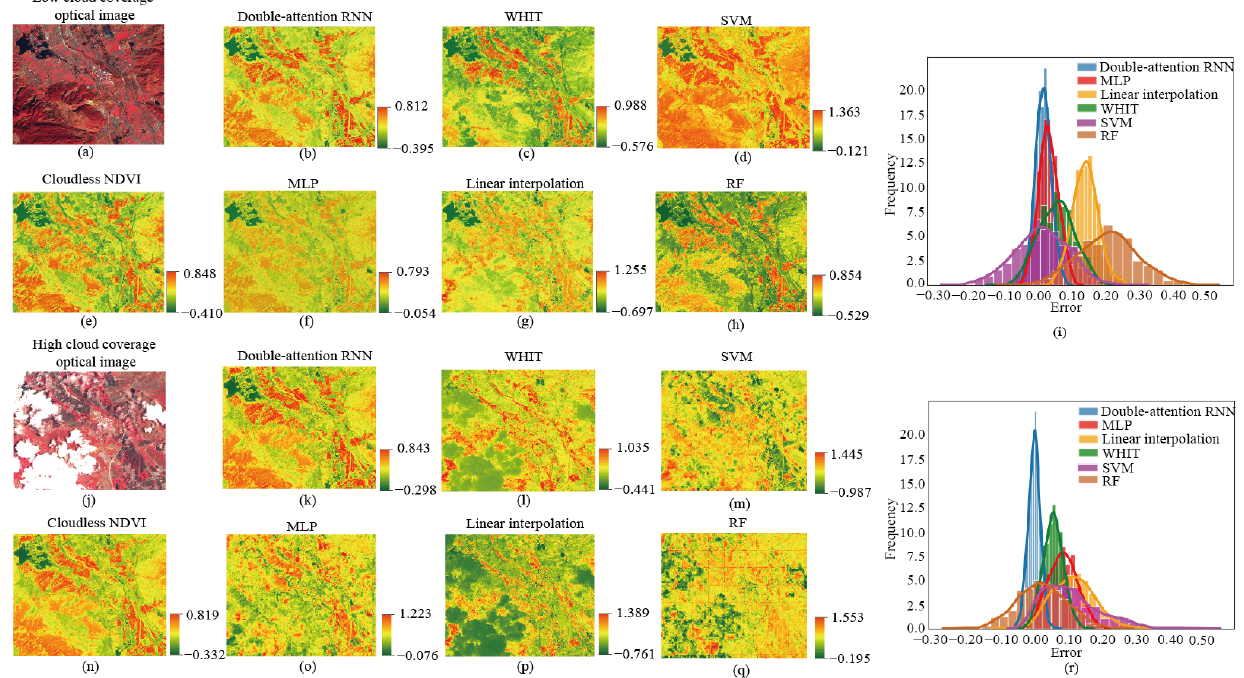
Figure 11. The NDVI retrieval results of the comparative models; ( a , j ) represent the optical images of low cloud coverage and high cloud coverage; ( e , n ) show the cloudless NDVI; ( b – d , f – h , k – m , o – q ) represent the retrieval results of the double-attention RNN, WHIT, MLP, linear interpolation, SVM, and RF; ( i , r ) present the error histogram plots, which integrate a bar graph and a line graph to show the error distributions of the comparative methods. The plot in cyan depicts the double-attention RNN, the red plot is the error histogram of the MLP network, the yellow plot represents linear interpolation, the error histogram of WHIT is in green, the fuchsia color is used for SVM, and RF is depicted in the chocolate color.